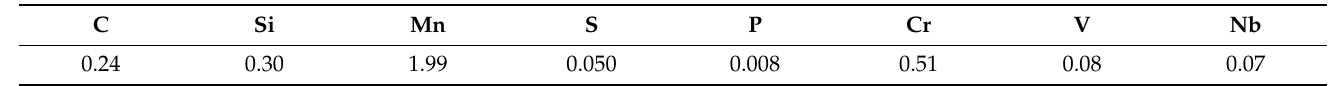
Table 1. Chemical composition of the low-carbon Nb-V-microalloyed forging steel